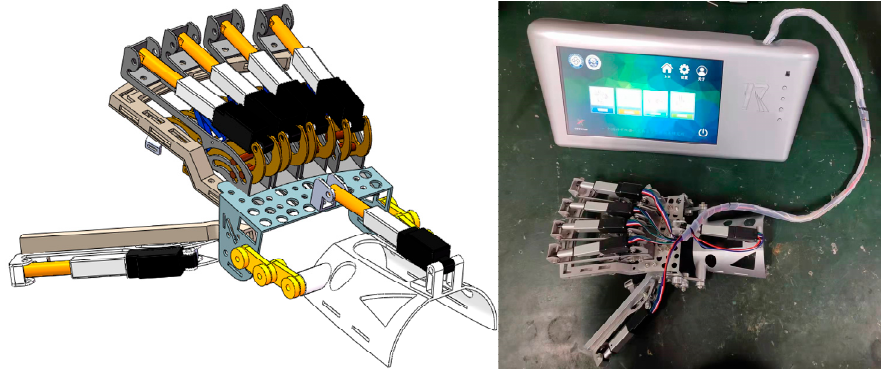
Figure 16. The model and prototype of hand robot after topology optimized.